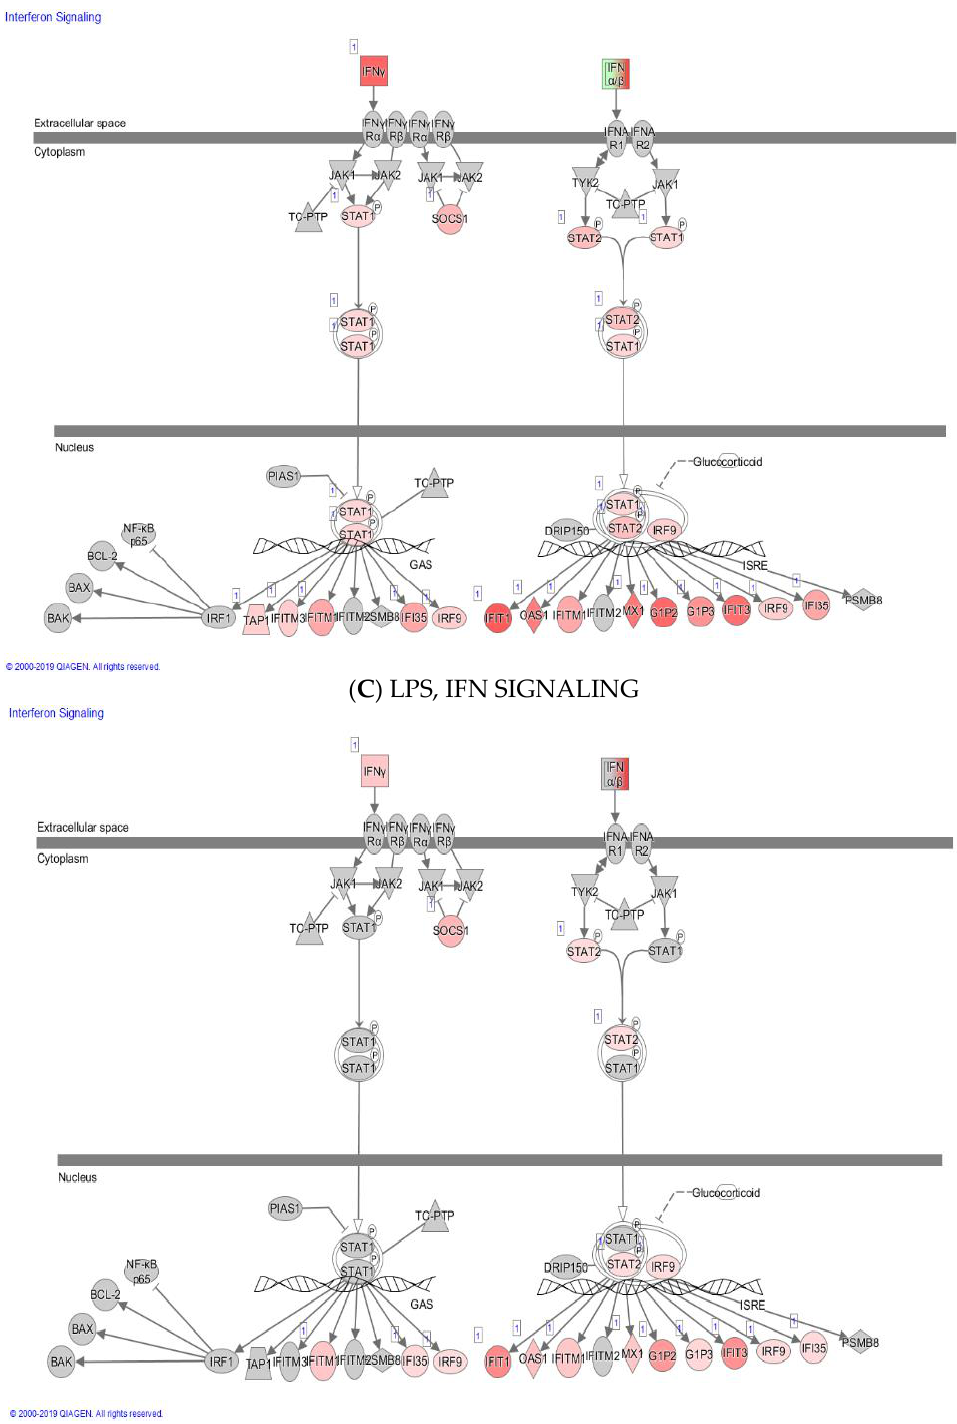
Figure 5. ( A – D ) The Interferon signaling pathway in human PBMCs. The interferon signaling pathway plays a critical role in the amplification of the immune response. The STAT1 and STAT2 transcription factors play a major role in the transcription of interferon activated genes. A. RES, B. LEC10, C. LPS, and D. LPS + RES. LPS and LEC activates gene expression of STAT1/STAT2, while RES downregulates it. Green, red, and grey colors denote inhibition, activation, and no change in gene expression, respectively.